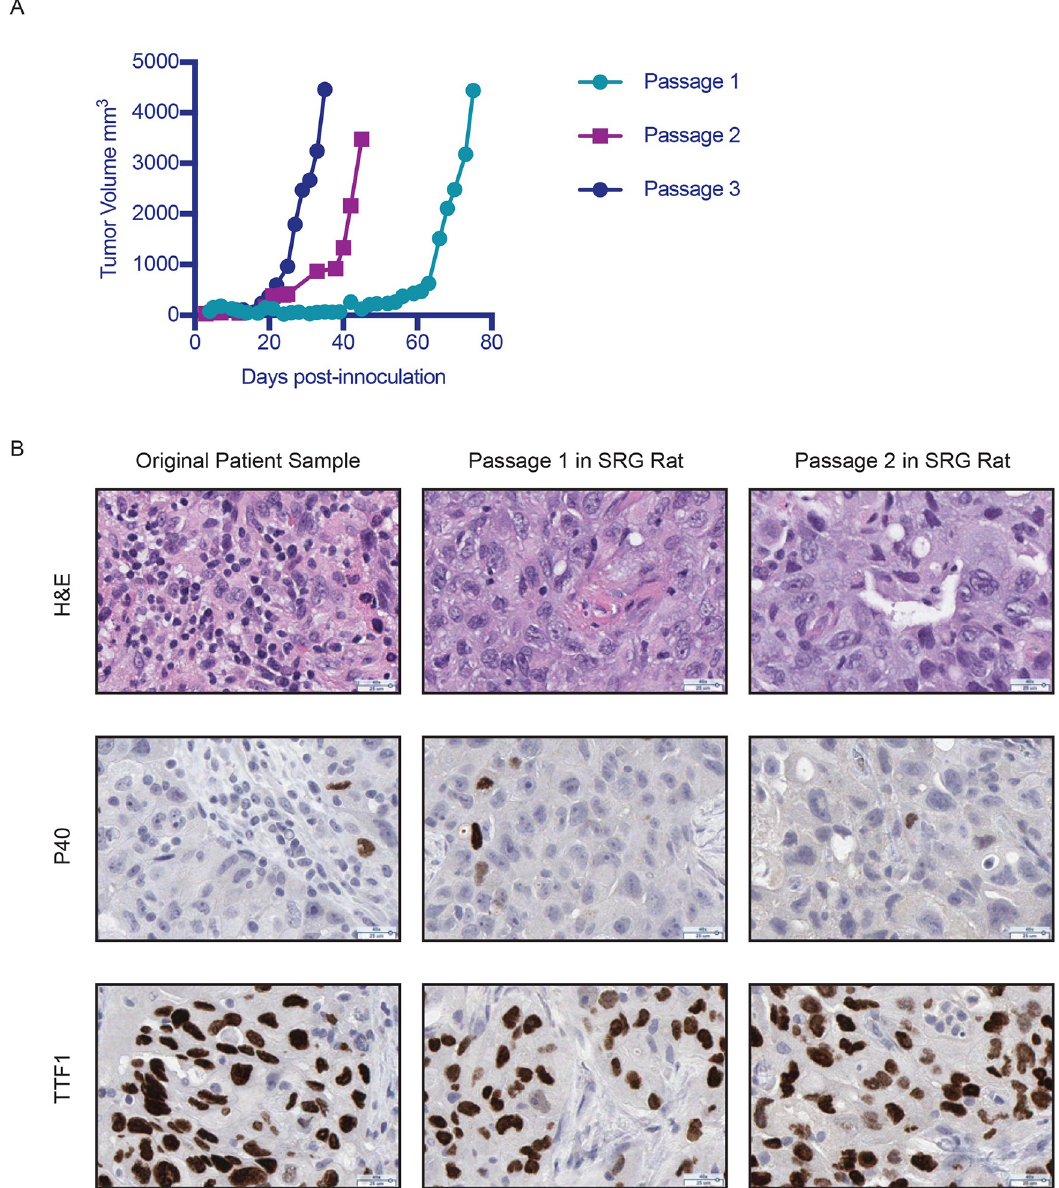
Fig 5. PDX model in the SRG rat. Patient derived lung tumor was implanted into SRG rats. A) Tumor growth curve shows multiple passages of the patient derived lung tumor from one patient and subsequent passages in the SRG rat. P1 is the initial passage in vivo in SRG rats. B) IHC staining for H&E, P40, and TTF1 in original patient tumor sample (3010), passage 1 of the same sample in SRG rat, and passage 2 of the same sample in SRG